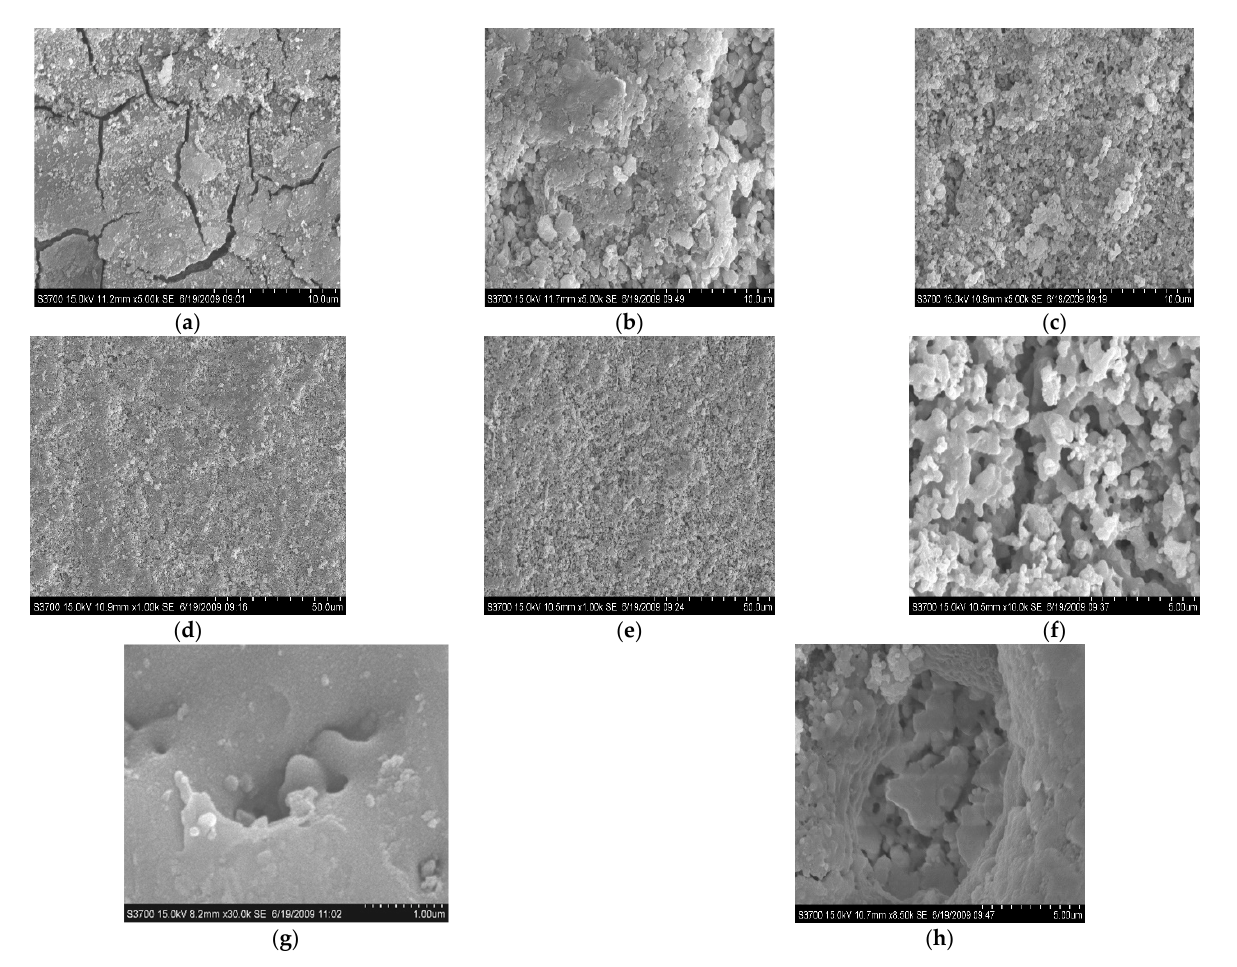
Figure 4. The surface morphologies of the membranes formed in K 2 ZrF 6 and NaH 2 PO 4 electrolytes at different voltage and time ( a ) 100 V-30 s; ( b ) 200 V-30 s; ( c ) 300 V-30 s; ( d ) 400 V-30 s ( e ) 420 V-30 s; ( f ) 466 V-10 min; ( g ) 466 V-10 min; ( h ) 466 V-10 min.